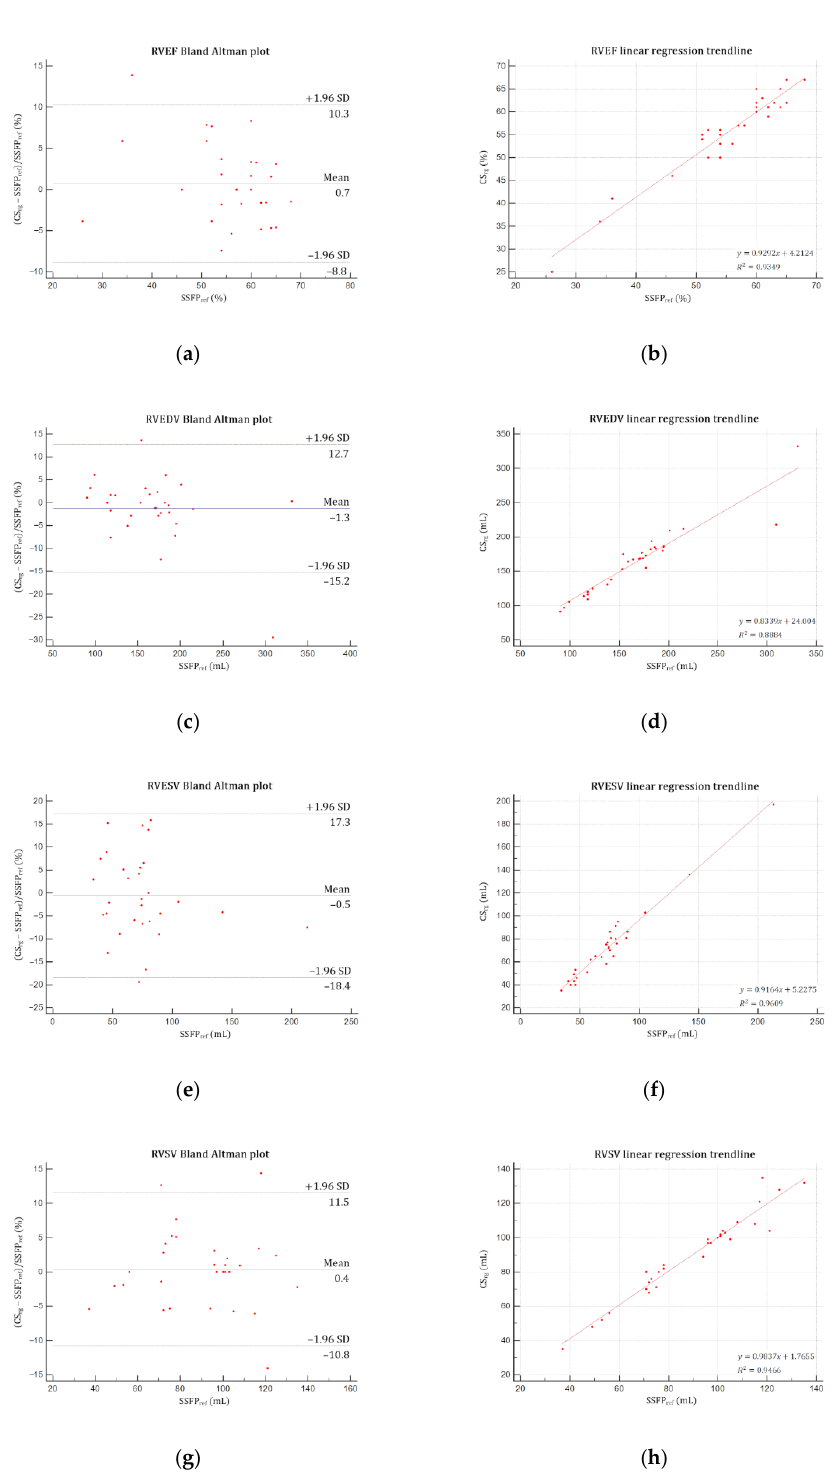
Figure 5. Bland–Altman plots and linear regression trendlines applied to right ventricular functional parameters quantifications. Left column: Bland-Altman plots for ( a ) RVEF, ( c ) RVEDV, ( e ) RVESV, and ( g ) RVSV. Solid blue lines are the mean differences between parameters measured with SSFP ref and CS rg sequences and dashed red lines are the 95% limits of agreement. Right column: linear regression trend lines for ( b ) RVEF, ( d ) RVEDV, ( f ) RVESV, and ( h ) RVSV. Abbreviations: SSFP ref , reference steady-state free precession; CS rg , retrogated compressed sensing; SD, standard deviation; RVEF, right ventricular ejection fraction; RVEDV, right ventricular end-diastolic volume; RVESV, right ventricular end-systolic volume; RVSV, right ventricular stroke